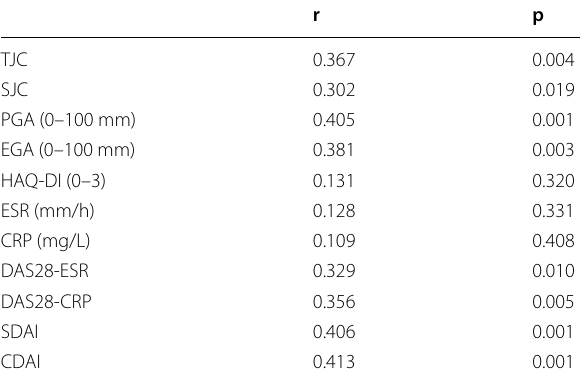
file 1: Table S2). All of the correlation coefficents (r value) were higher than 0.5.